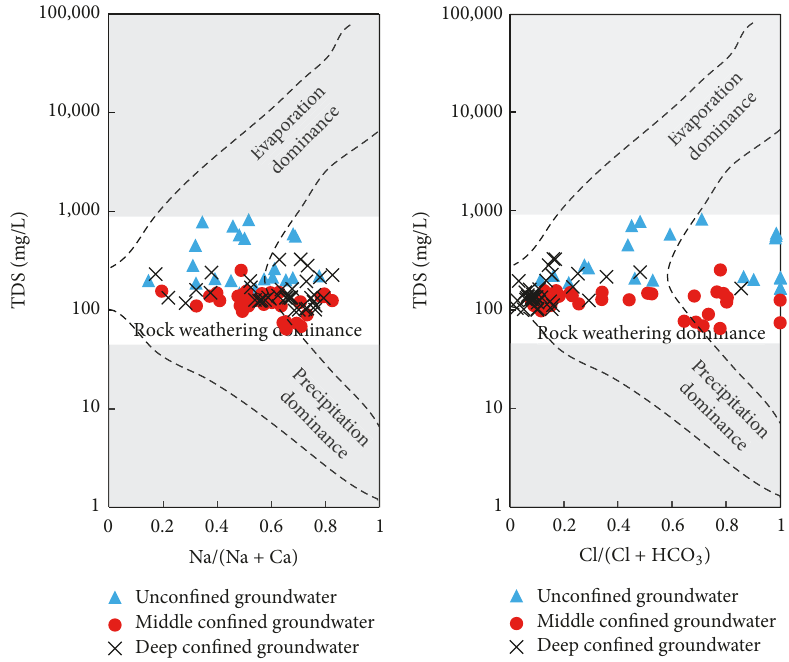
Figure 6: Gibbs plots of the major ions in the coastal groundwater of Zhanjiang.